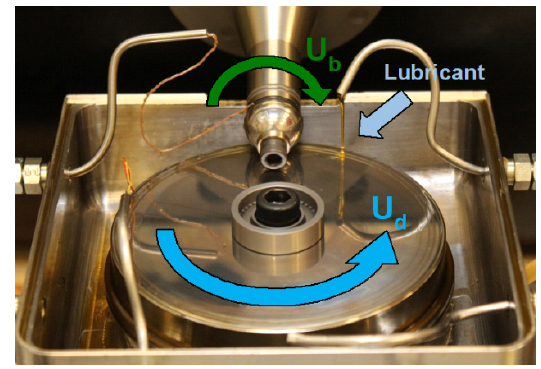
Figure 1. High speed ball-on-disk tribometer experimental setup.